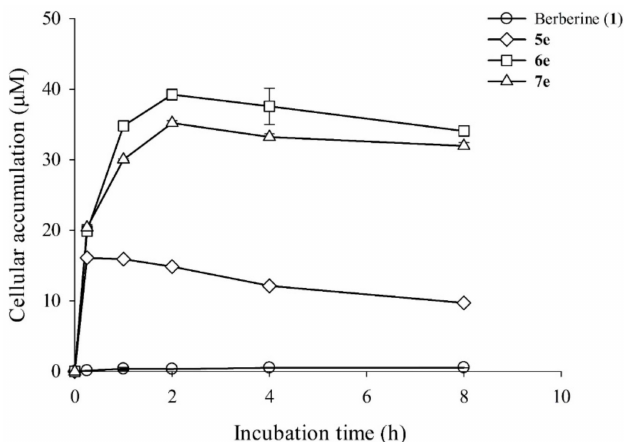
Figure 4. Intracellular accumulation of berberine ( 1 ) and its derivatives ( 5e , 6e, and 7e ) in HepG2 cells. HepG2 cells (1 × 10 6 ) were treated with 10 µ M of berberine and its derivatives ( 5e , 6e, and 7e ) and then incubated for 0 h, 0.25 h, 1 h, 2 h, 4 h, or 8 h. Intracellular concentrations of berberine ( 1 ) and its derivatives ( 5e , 6e, and 7e ) were detected using HPLC analysis. Data are shown as the mean ± SD (n = 3) of two independent experiments.